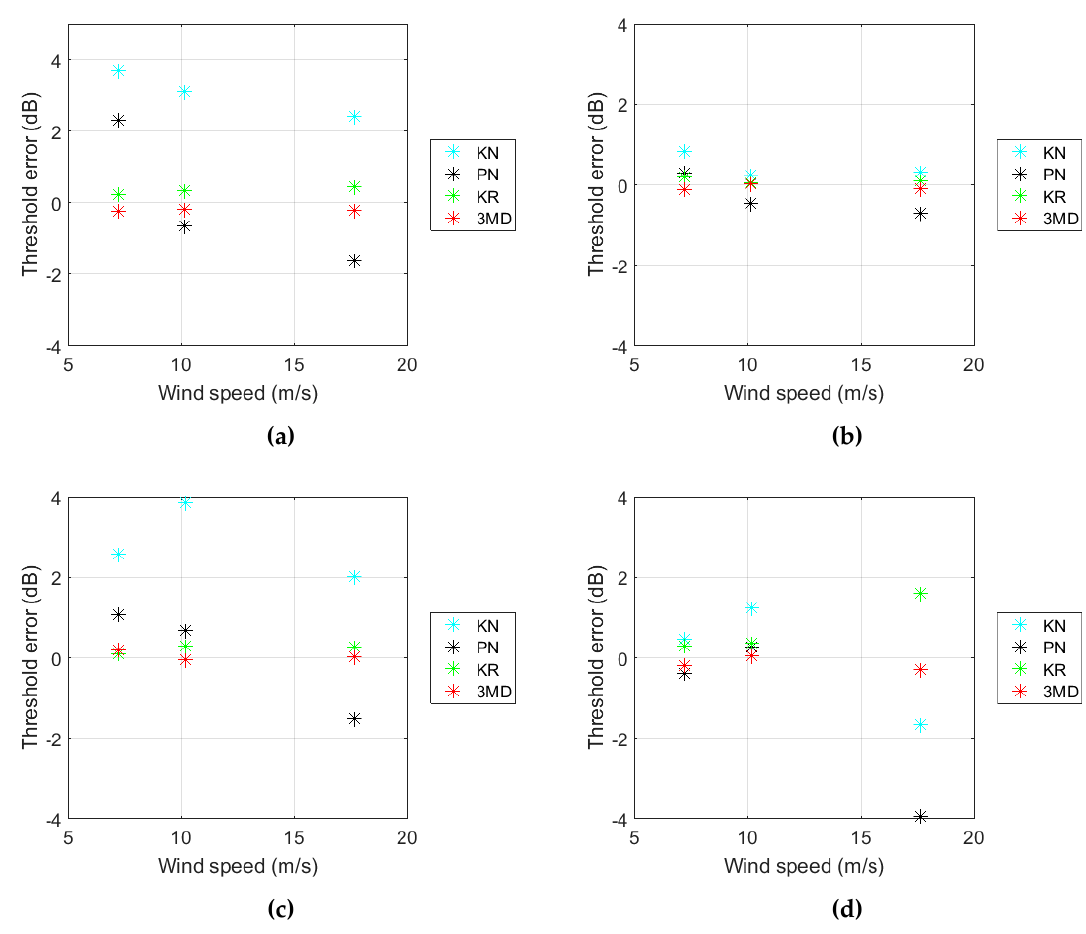
Figure 22. Threshold error against windspeed for the SETHI X-band dataset. Threshold error is measured at a CCDF of 10 − 4 . ( a ) HH polarization, 10 ◦ grazing; ( b ) VV polarization, 10 ◦ grazing; ( c ) HH polarization, 20 ◦ grazing; ( d ) VV polarization, 20 ◦ grazing.